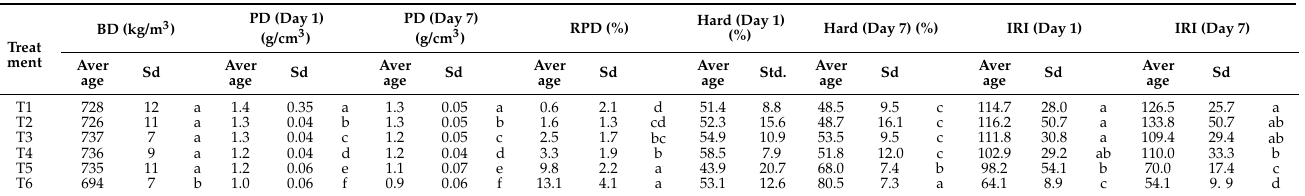
Table 5. Physical and mechanical properties of pellets made with Agave durangensis fibers and Pinus spp. sawdust mixtures.